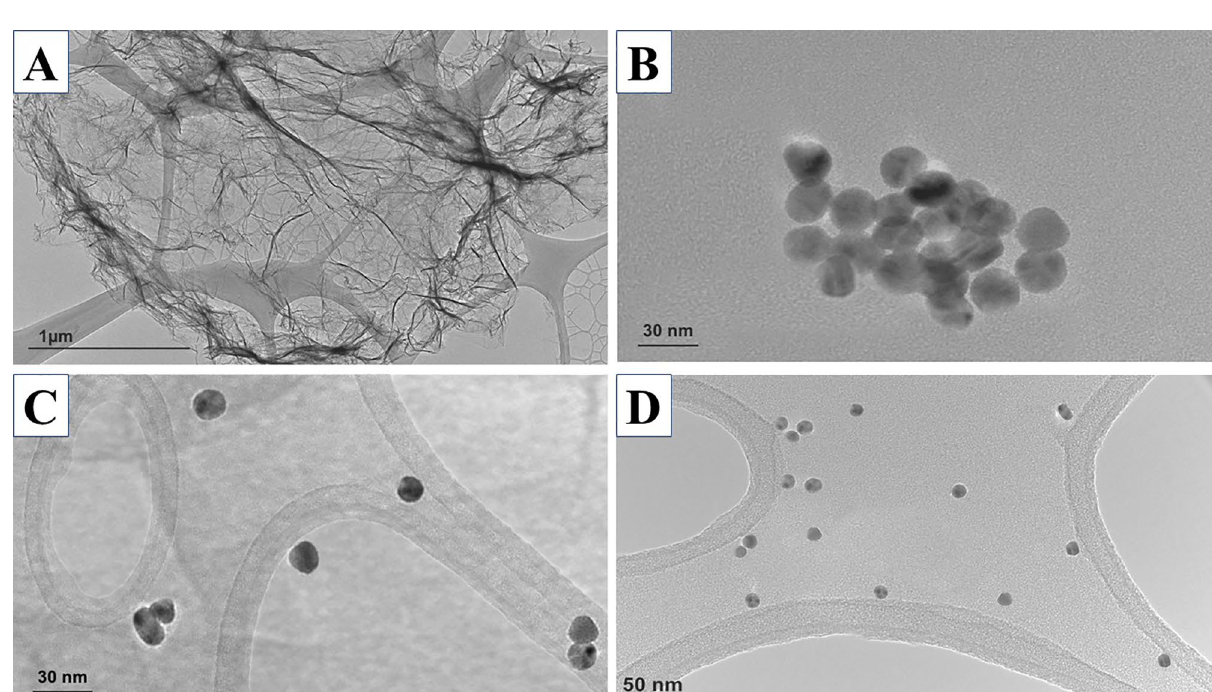
Figure 2. The HR-TEM micrograph of synthesized ( A ) GO, ( B ) AuNPs, ( C ) GO/AuNPs, and ( D ) SCVP1-3 capped